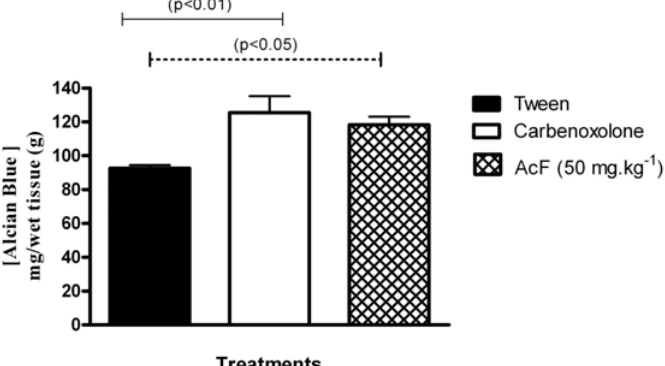
The columns are the mean ± S.D. of five rats. ANOVA: F